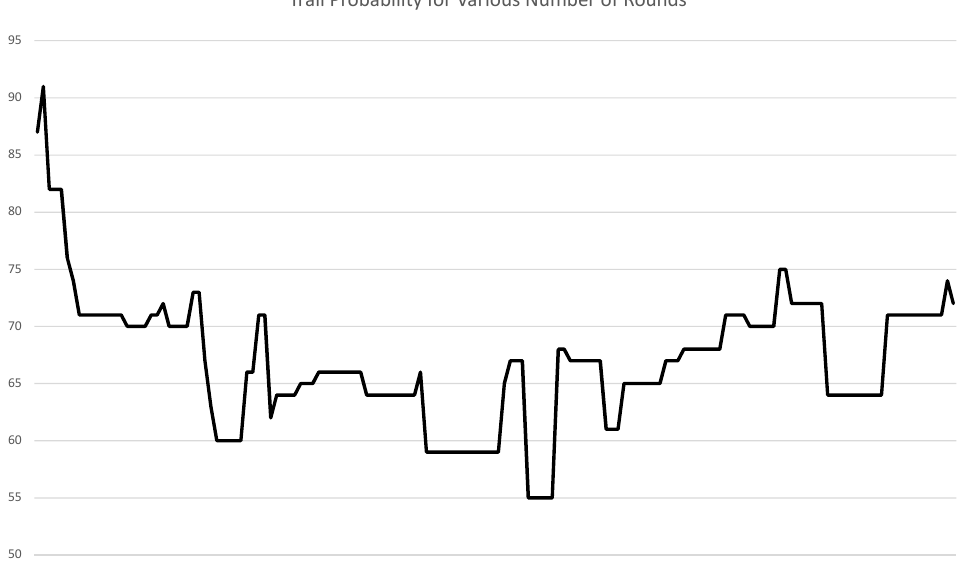
Figure 8: Graph of Table 6. Vertical axis denotes the score and horizontal axis denotes the number of